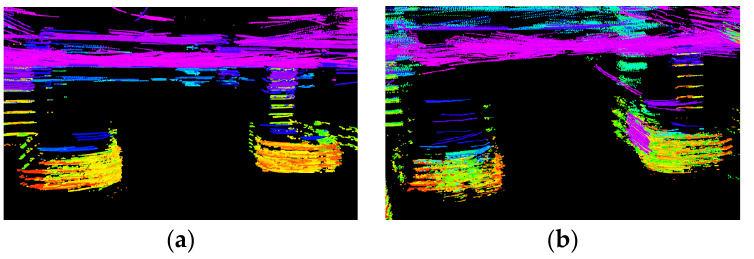
Figure 2. Point cloud visualization results after SegMatch segmentation and feature extraction: ( a ) for the source point cloud; and ( b ) for the target point cloud.